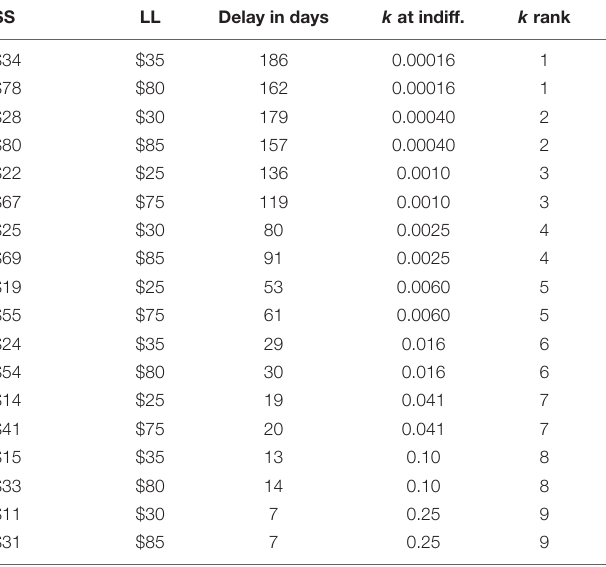
TABLE 1 | Abbreviated Monetary Choice